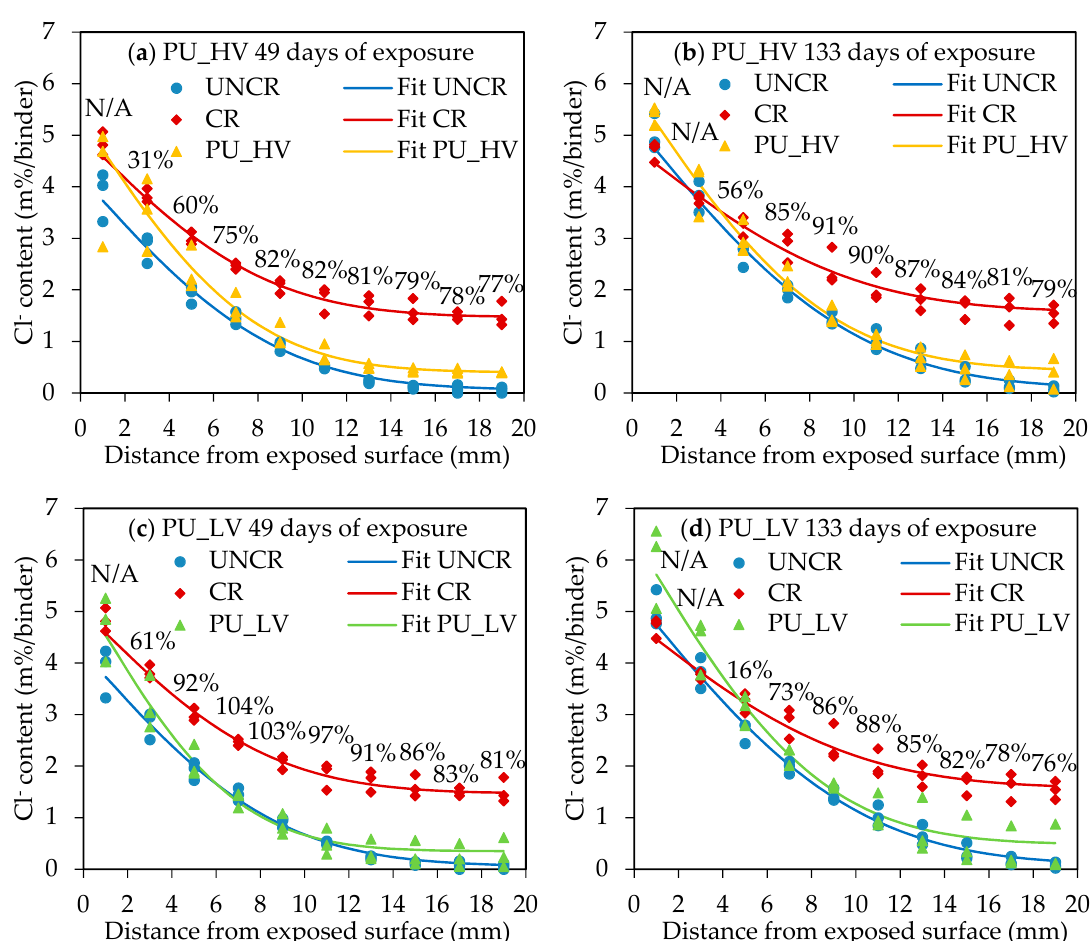
Figure 4. Experimental and fitted chloride profiles for (un)cracked and healed concrete with PU_HV after ( a ) 49 and ( b ) 133 days; and healed concrete with PU_LV after ( c ) 49 and ( d ) 133 days of exposure in 165 g/L NaCl solution. The self-healing efficiency (SHE) of each layer is denoted above the curves.